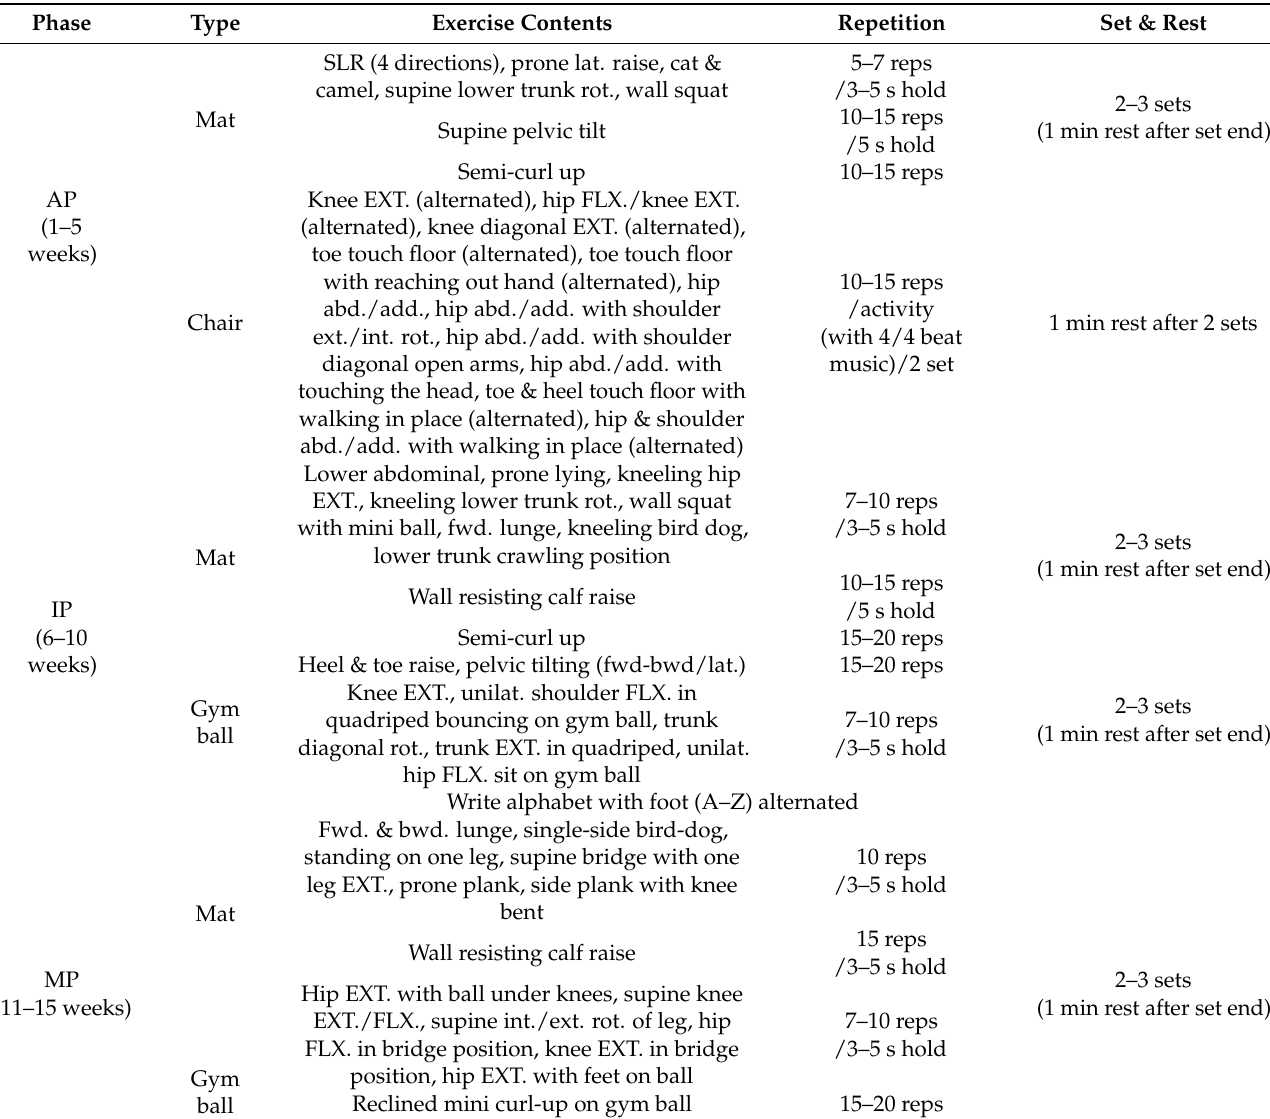
Table 3. Details of the mat, chair, and gym ball exercises of the 15-week complex exercise program.